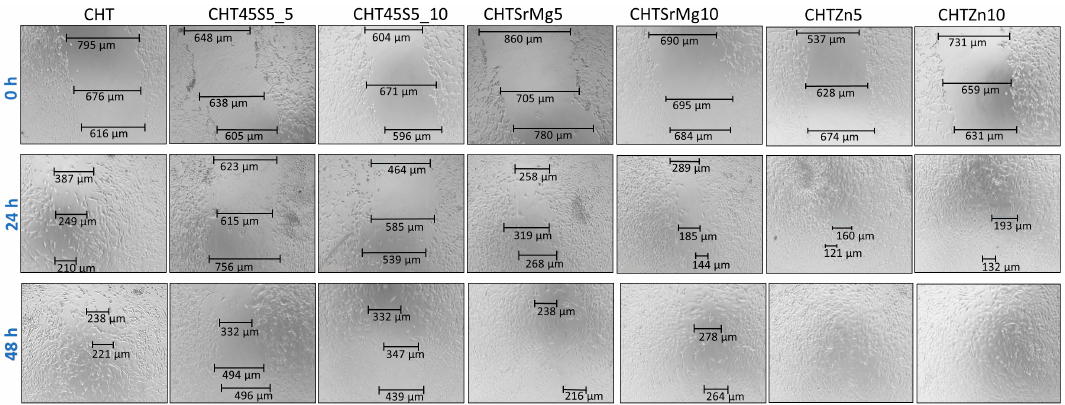
Figure 7. Cell migration using NIH 3T3 in contact with eluates of CHT, CHT45S5_5, CHT45S5_10, CHTSrMg5, CHTSrMg10, CHTZn5, and CHTZn10 wound dressings.